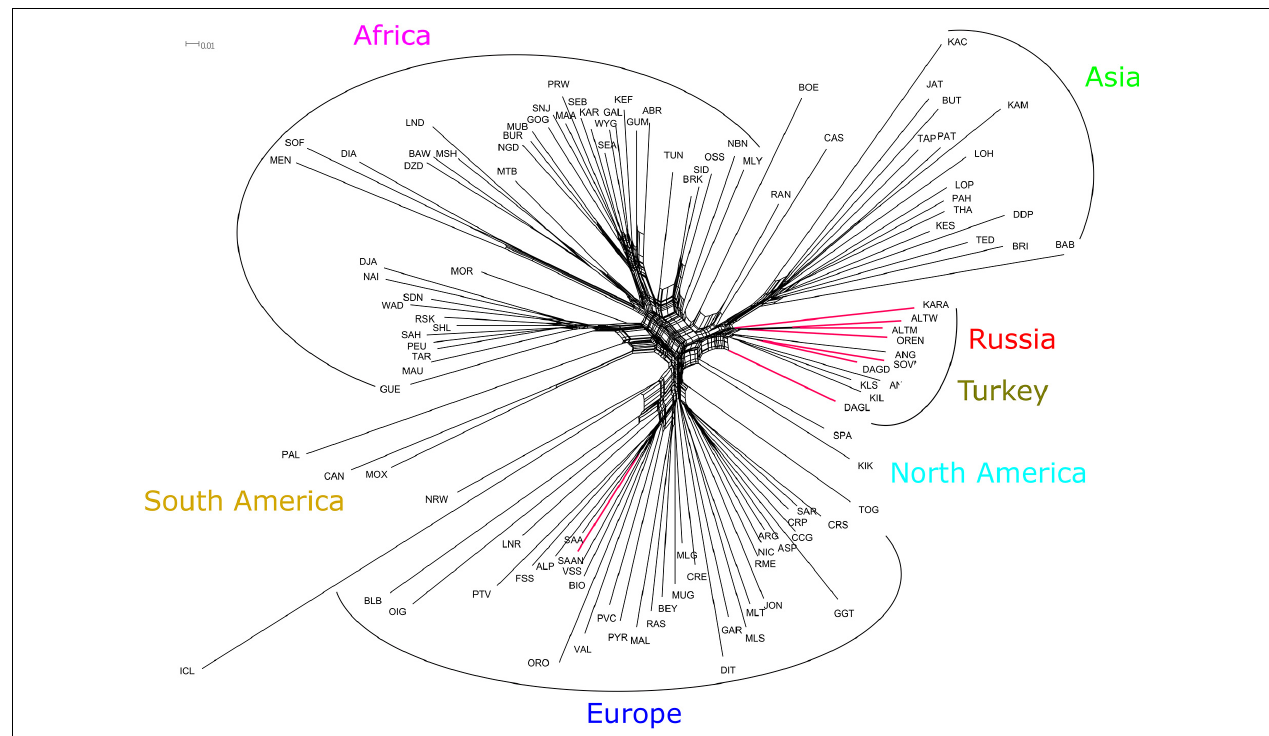
FIGURE 5 | Neighbor-Net graph based on Reynolds distances for Russian and worldwide goat populations from AdaptMap. Branches for Russian local goats are colored red. For a description of the goat breeds, see Table 1 .